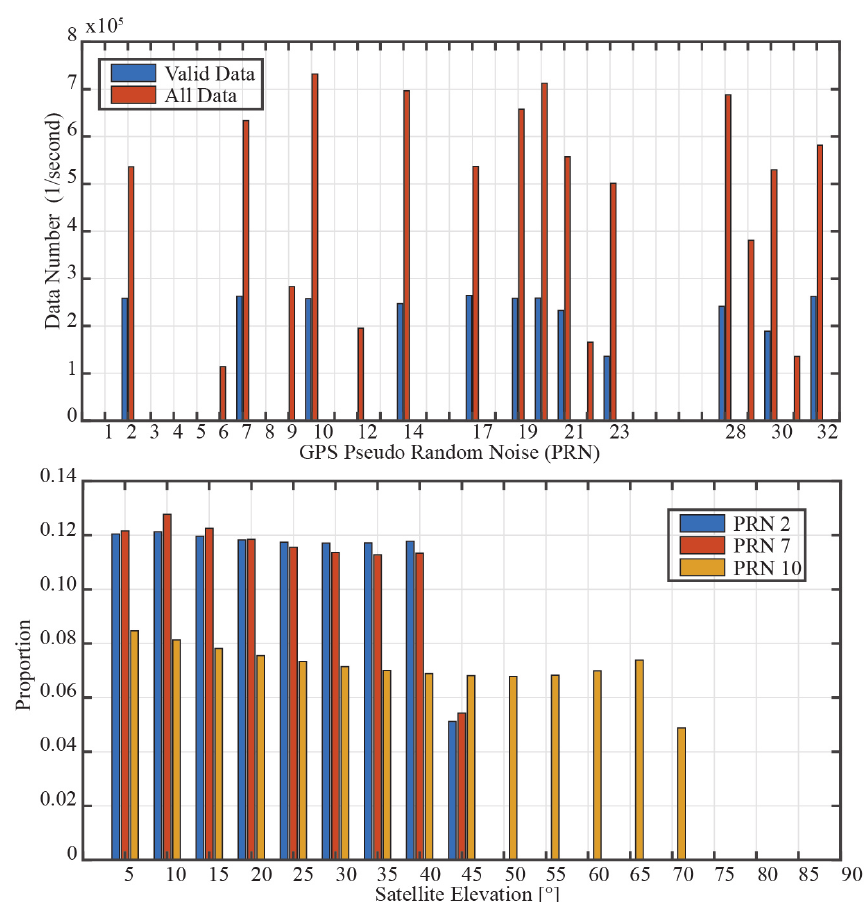
Figure 7. The proportion of valid satellite data of all satellites (upper panel), PRN2, 7, and 10 (bottom